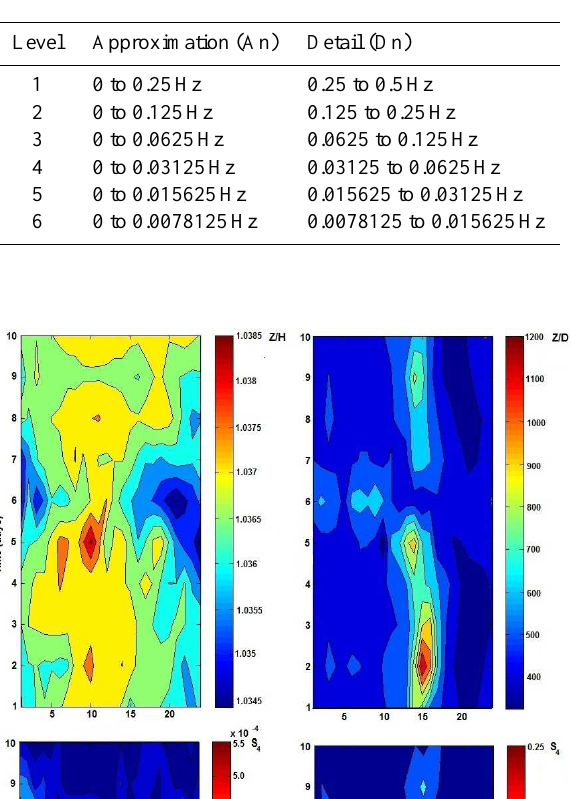
Table 2. DWT decomposition bandwidths in Hz for a sampling frequency f s =1Hz.